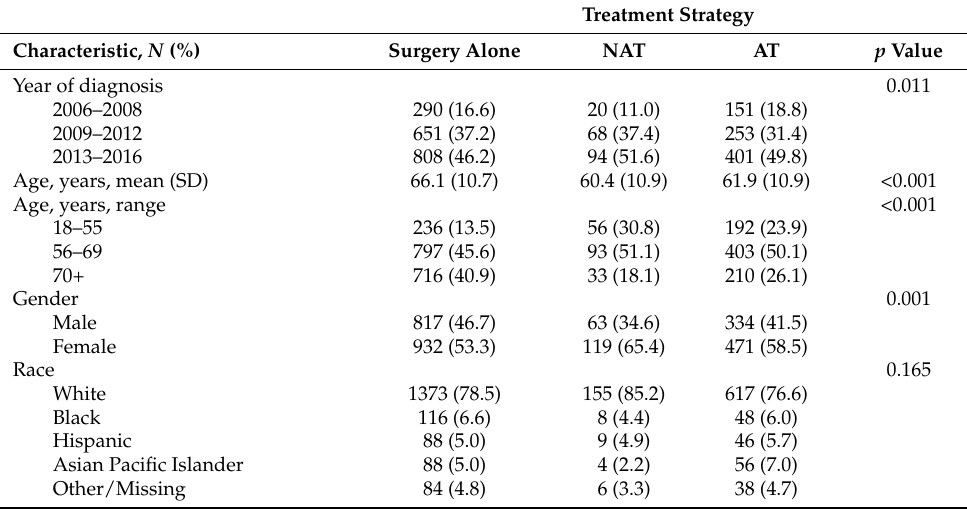
Table 1. Baseline demographic and tumor characteristics by treatment strategy. Abbreviations as follows, NAT: neoadjuvant therapy; AT: adjuvant